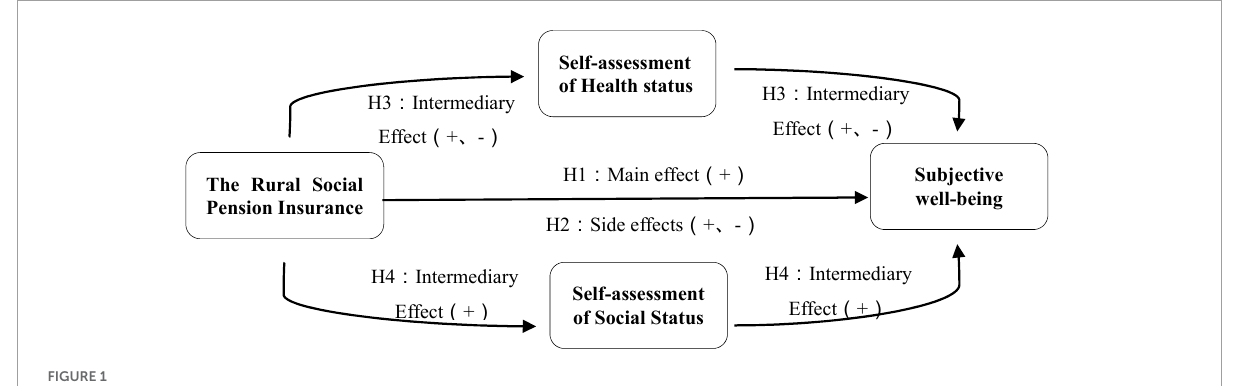
FIGURE1 Theoretical hypothesis model of social insurance and subjective well-being.